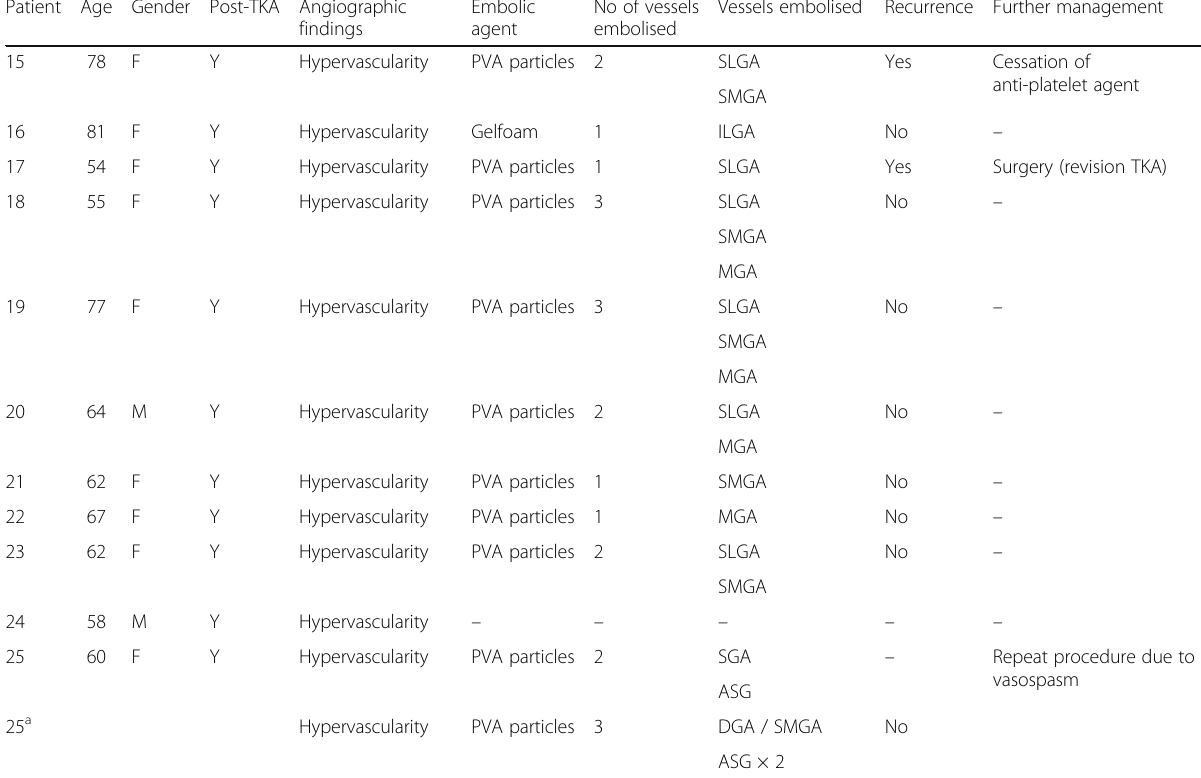
Table 1 Characteristics and procedure details for patients undergoing angiography and embolization for recurrent hemarthrosis of the knee (Continued) Patient Age Gender Post-TKA Angiographic